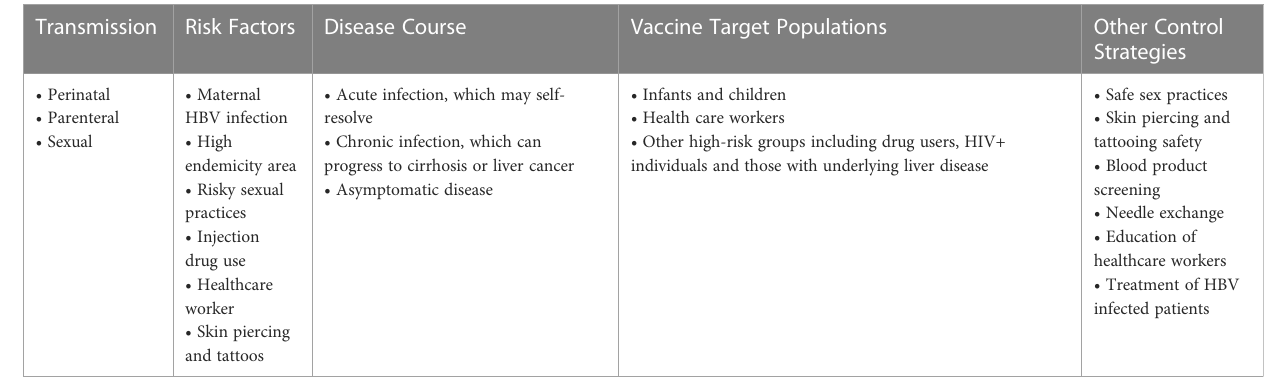
TABLE 1 HBV. Transmission Risk Factors Disease Course Vaccine Target Populations Other Control